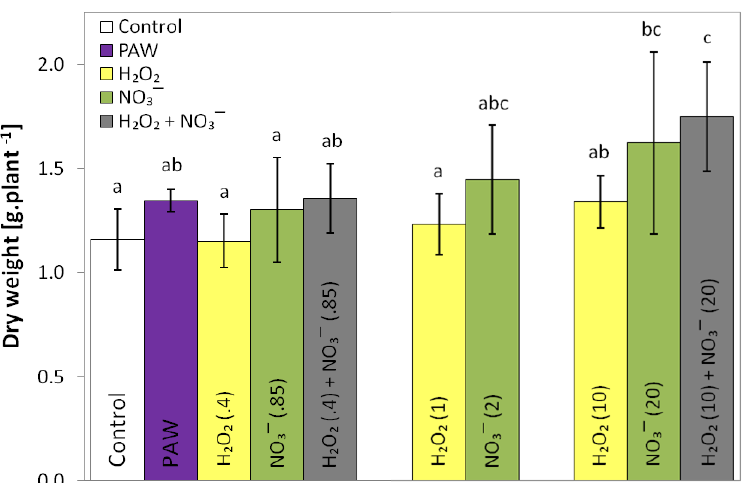
Figure 3. Dry weight of above-ground parts of lettuce plants after 5 weeks of soil cultivation irrigated with the plasma activated water (PAW), solutions of various concentrations of H 2 O 2 (0.4, 1, 10 mM), NO 3 − (0.85, 2, 20 mM), H 2 O 2 + NO 3 − (0.4 mM + 0.85 mM, 10 mM + 20 mM) and control irrigated with tap water. The data are presented as mean values ± standard deviation from 3 independent repetitions. The lowercase letters represent statistically significant difference at probability p < 0.05.